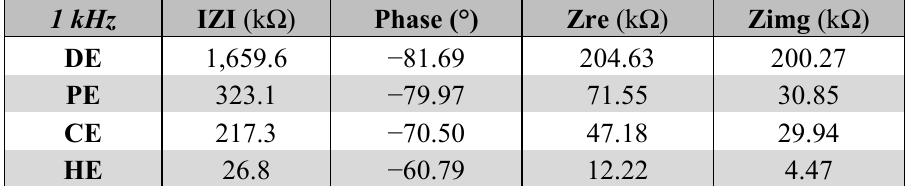
Table 1. The values of impedance module, real part and imaginary part, phase shift and capacitance measured for the electrodes at 1 kHz